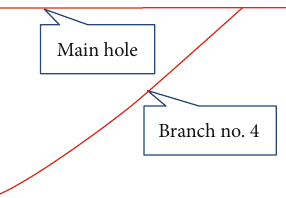
Figure 19: Sketch map of No. 4 branch and main tunnel of Qinling Mountains section of Han to the Wei River project in